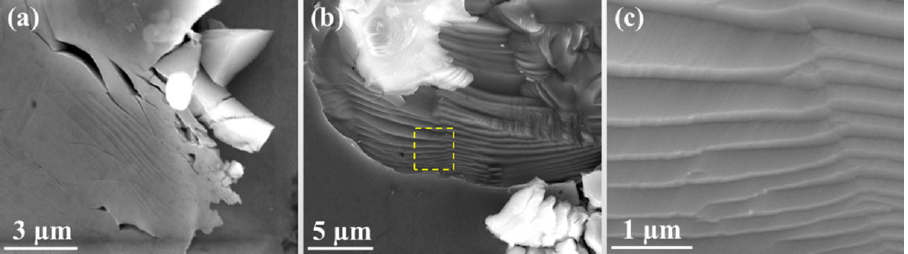
Fig. 6 Surface morphologies of sample sintered at 1500 ℃ after Vickers indentation test: (a) basal Y 3 Si 2 C 2 plane oriented parallel to the load with the presence of kinks, delamination, and slipping; (b) basal Y 3 Si 2 C 2 plane oriented perpendicular to the load showing the exfoliation; and (c) high magnification SEM image showing the nano-laminated structure of Y 3 Si 2 C 2